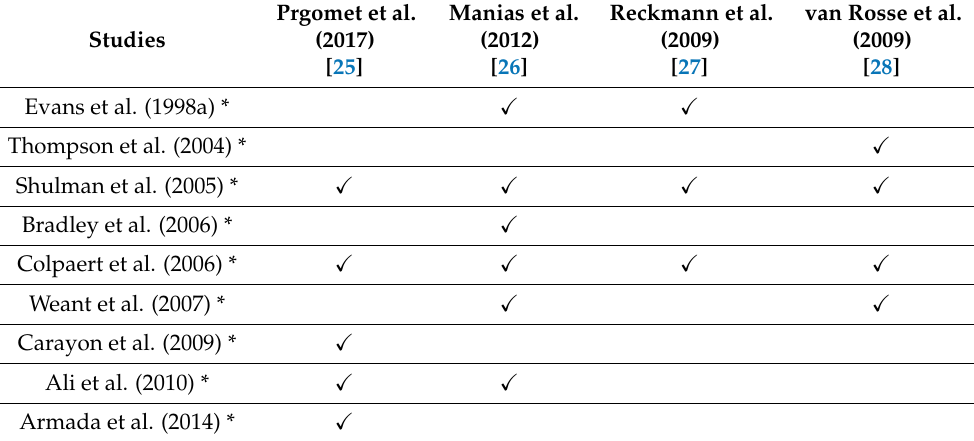
Table 2. Studies on CPOE included in the systematic review included in this umbrella review.